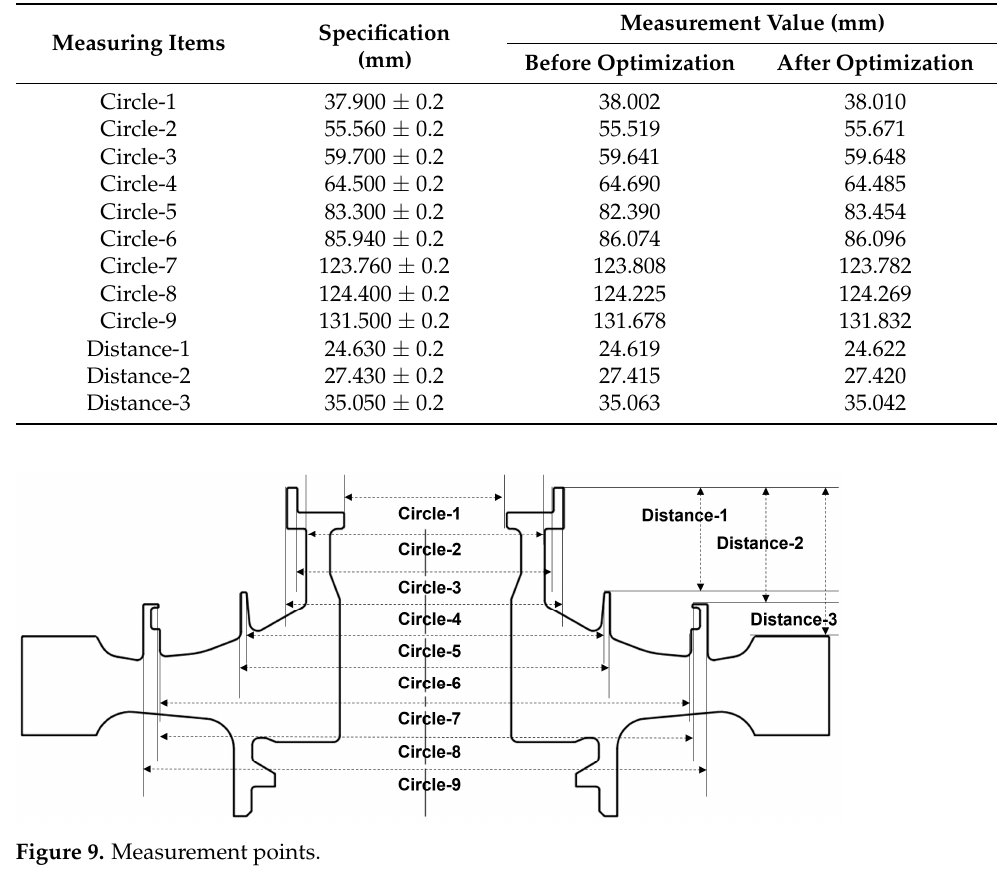
Table 6. The measurement results of machining accuracy.